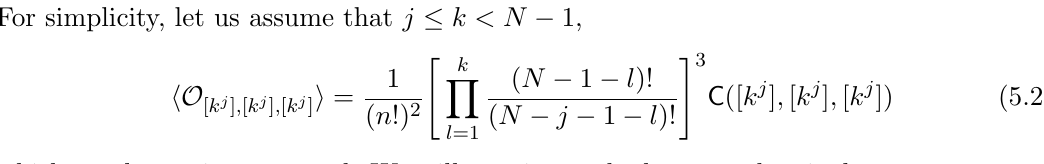
i , for n = 2 k (left) and of hO [ k 2 ] ; [ k 2 ] ; [ k 2 ]